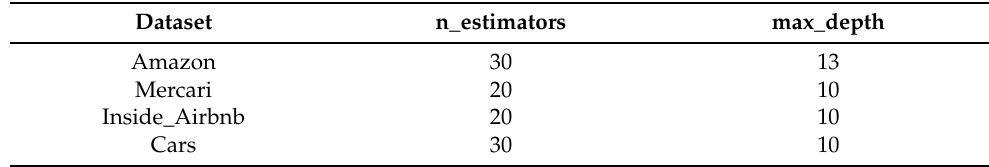
Table 1. Scikit-learn random forest